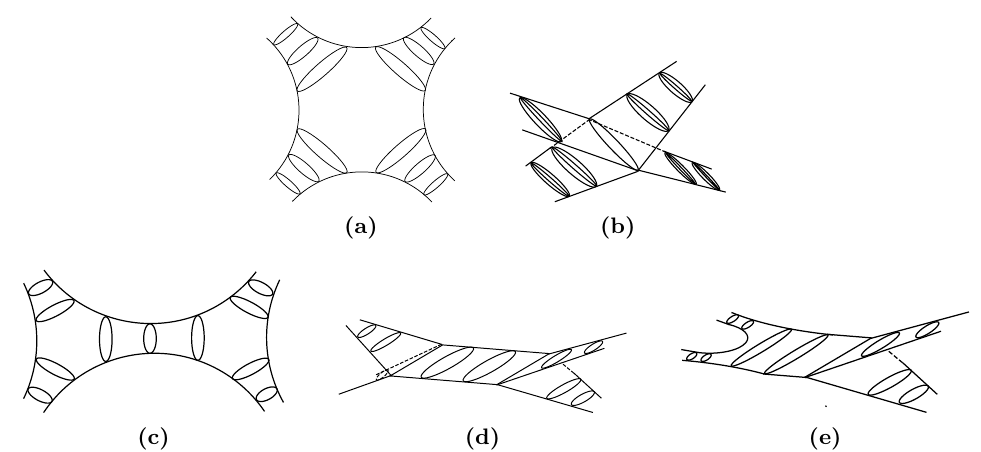
Figure 10. Diagrams contributing to the fermion eight-point function. Note that (b) only exists for q > 4, so we have drawn it for q = 6. All other diagrams are for q =